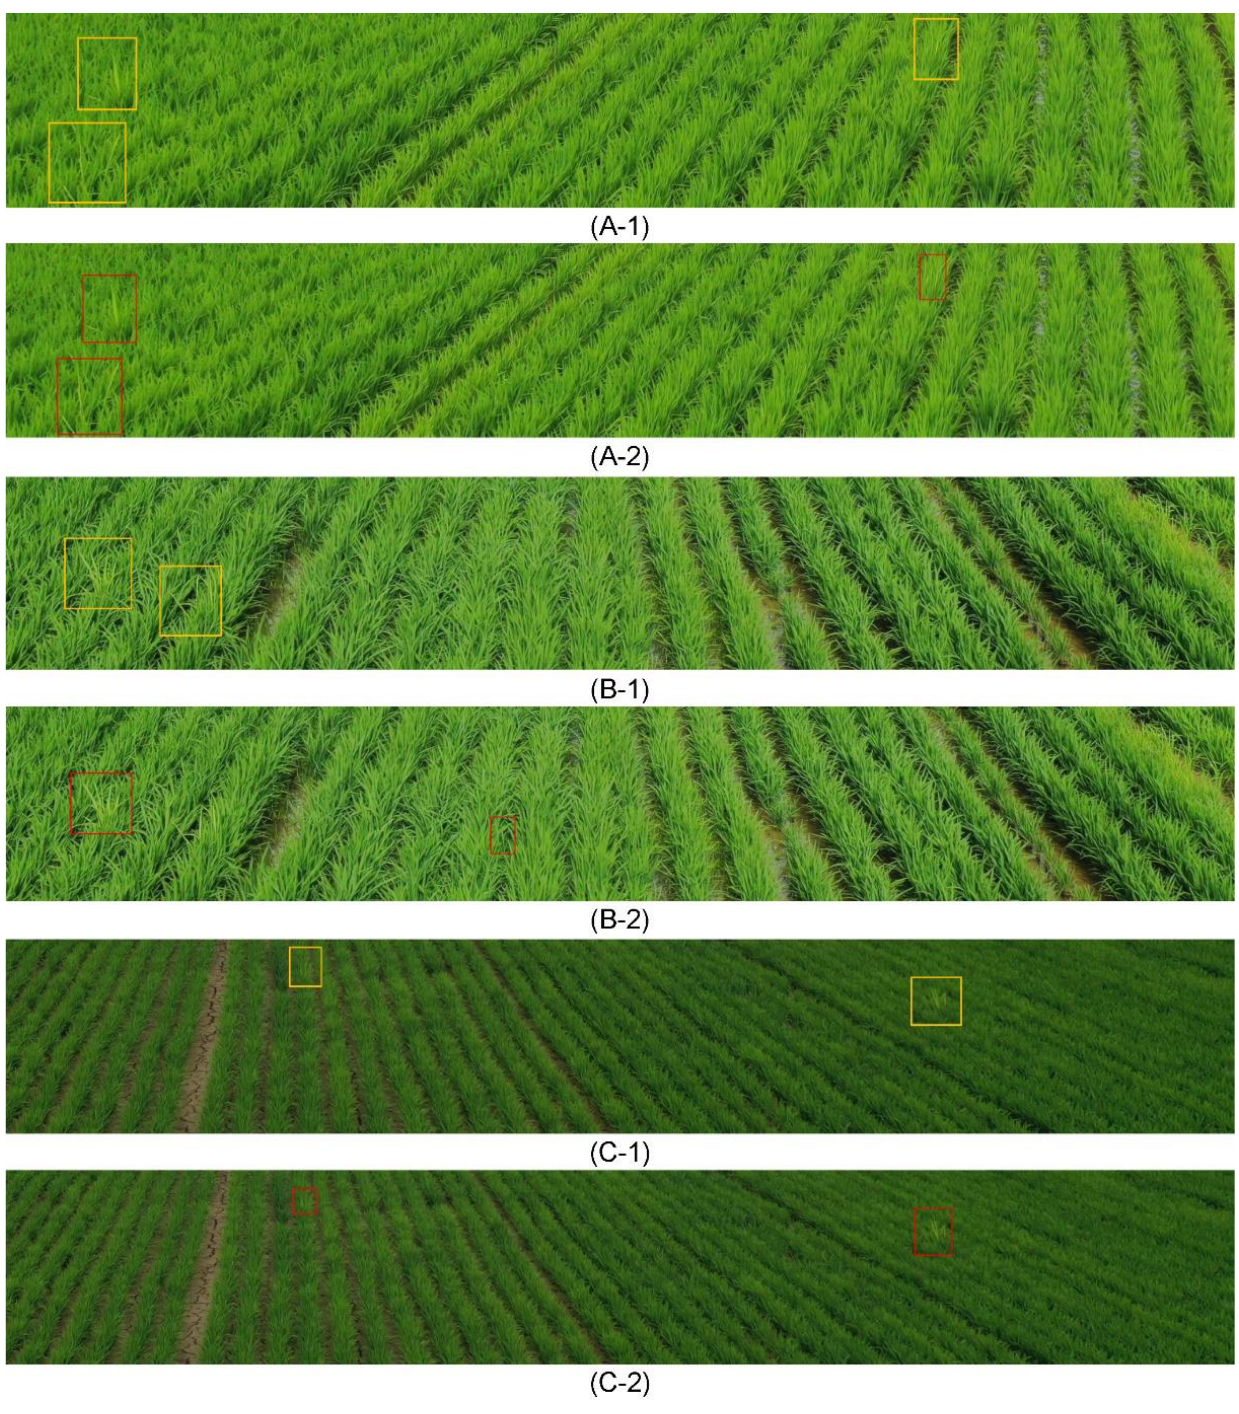
Figure 20. YOLOv3 model-based RBD bunch area detection results (Yellow boxes represent the ground truths, and red boxes represent the detection results): ( A – C ) Each detection task, ( 1 ) Ground truth, and ( 2 ) predicted result.